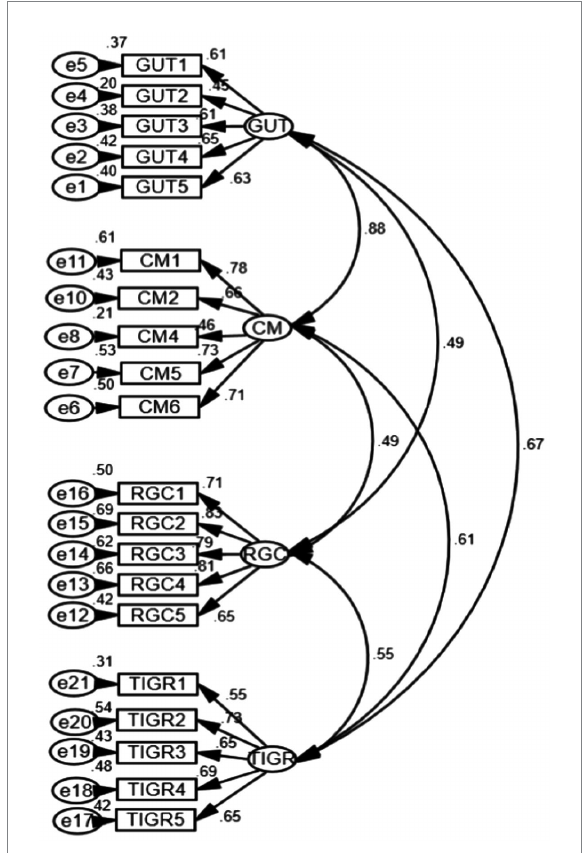
FIGURE 1 The confirmatory factor analysis result of C-DNAS (GUT, grow up with technology; CM, comfortable with multitasking; RGC, reliant on graphics for communication; TIGR, thrive on instant gratification and rewards).